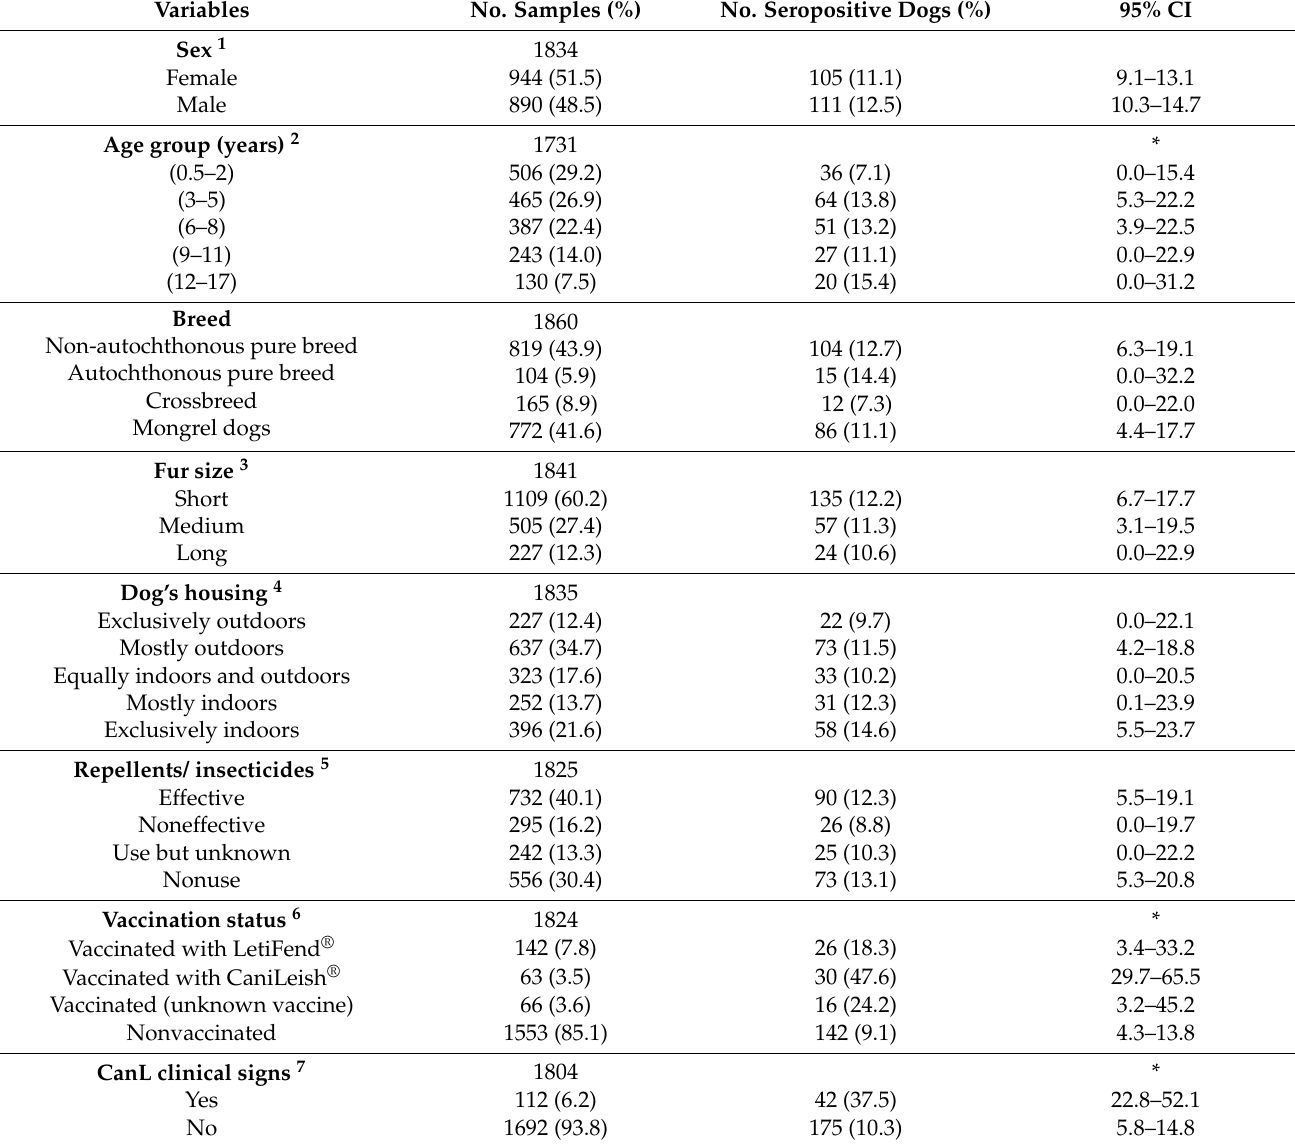
Table 2. Number of samples and dogs’ seropositivity per sex, age, breed, fur size, housing, repellents/ insecticide use, vaccination status and presence of canine leishmaniosis clinical